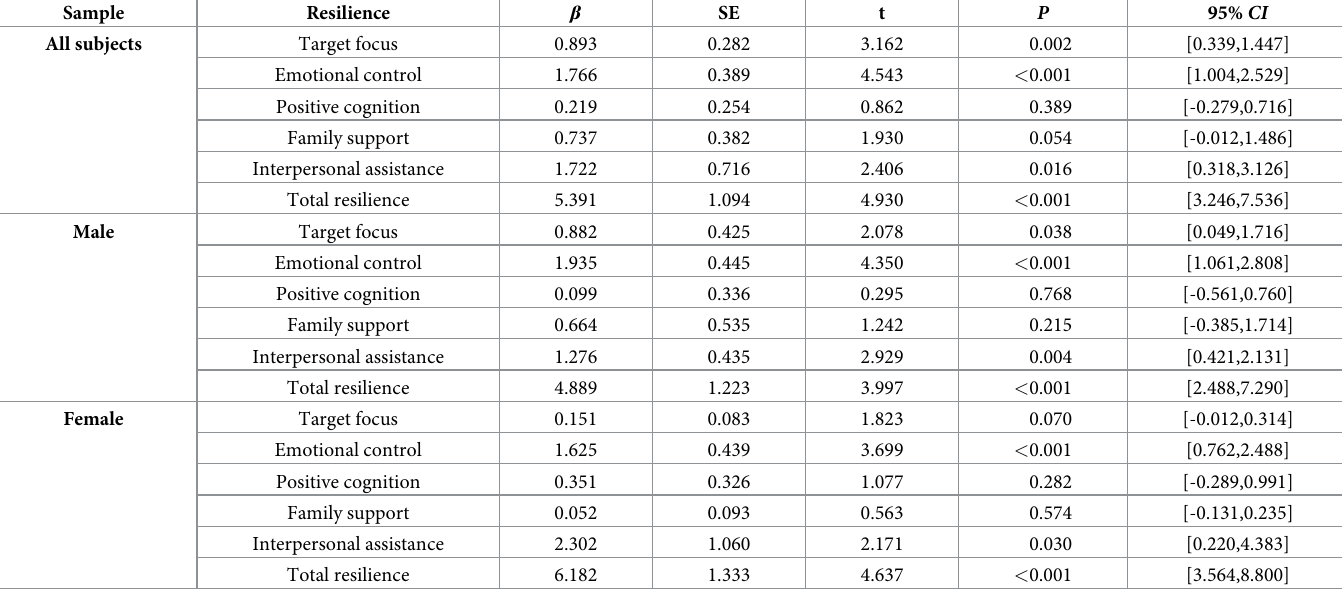
Table 4. The effect of peer education between the intervention group and the control group (n = 1338).